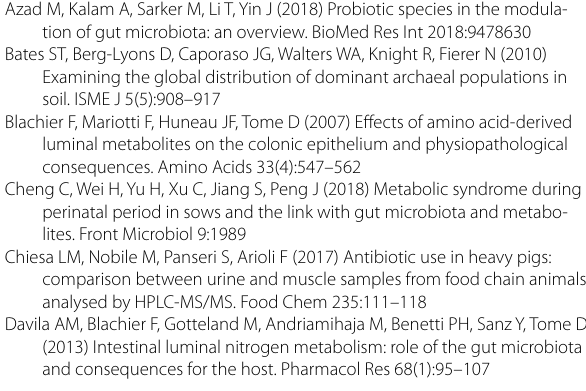
Additional file 1: Table S1. Concentrations of indole and skatole, short-chain fatty acids and bioamines in the colonic contents of pig after supplementation with different doses of XOS in pigs at different stages of